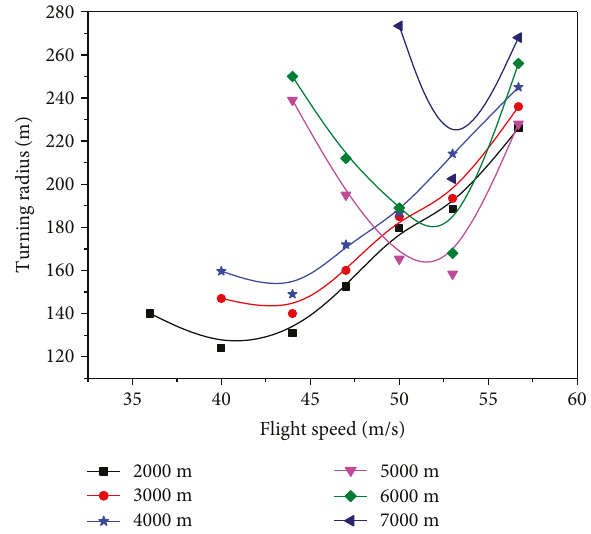
Figure 13: Thrust di ff erences between available and required thrust at di ff erent altitudes.